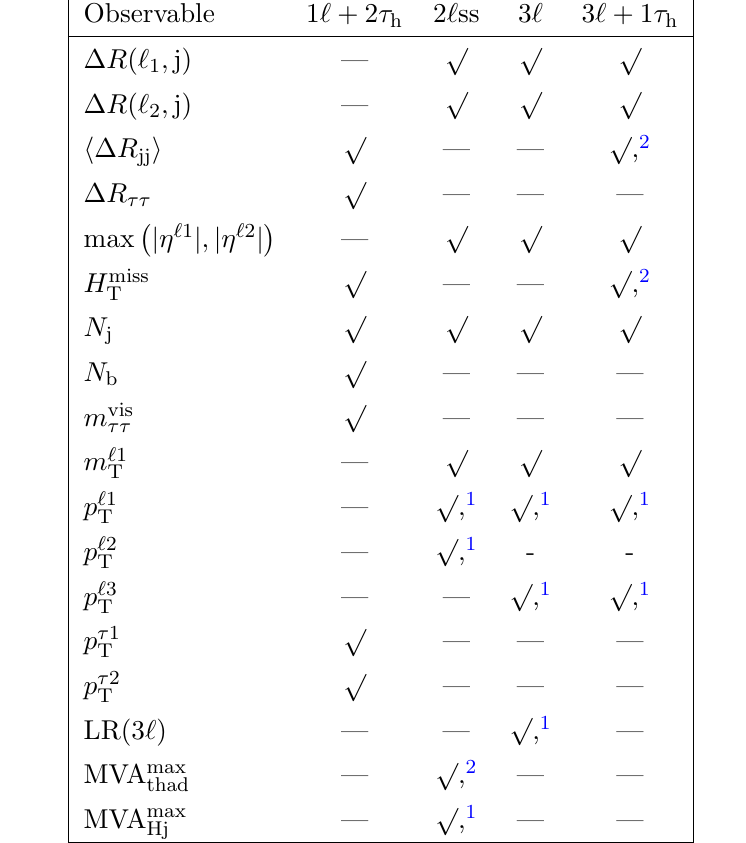
Table 3 . Observables used as input to the BDTs that separate the ttH signal from the ttV and tt+jets backgrounds in the 1 ‘ + 2 (cid:28) h , 2 ‘ ss, 3 ‘ , and 3 ‘ + 1 (cid:28) h categories. individually, and separate optimizations are performed for the BDT that separates the signal from the ttV background and the one that separates the signal from the tt+jets